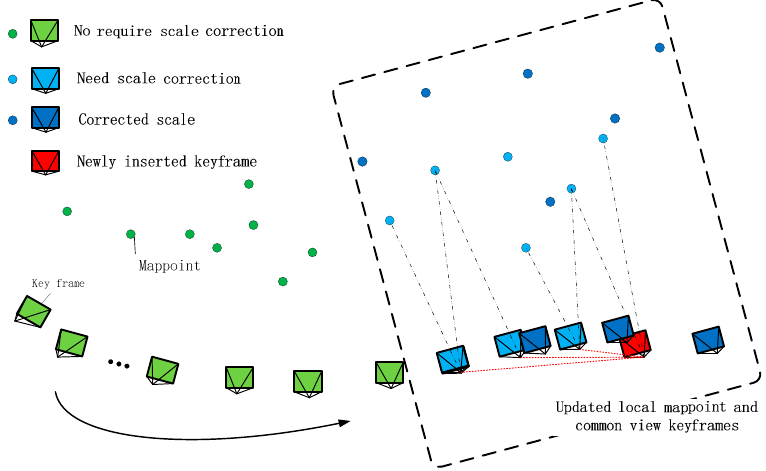
Figure 4. The proposed strategy of the scale correction. The update strategy will be triggered when the drift meets the conditions in Equations (21) and (22).